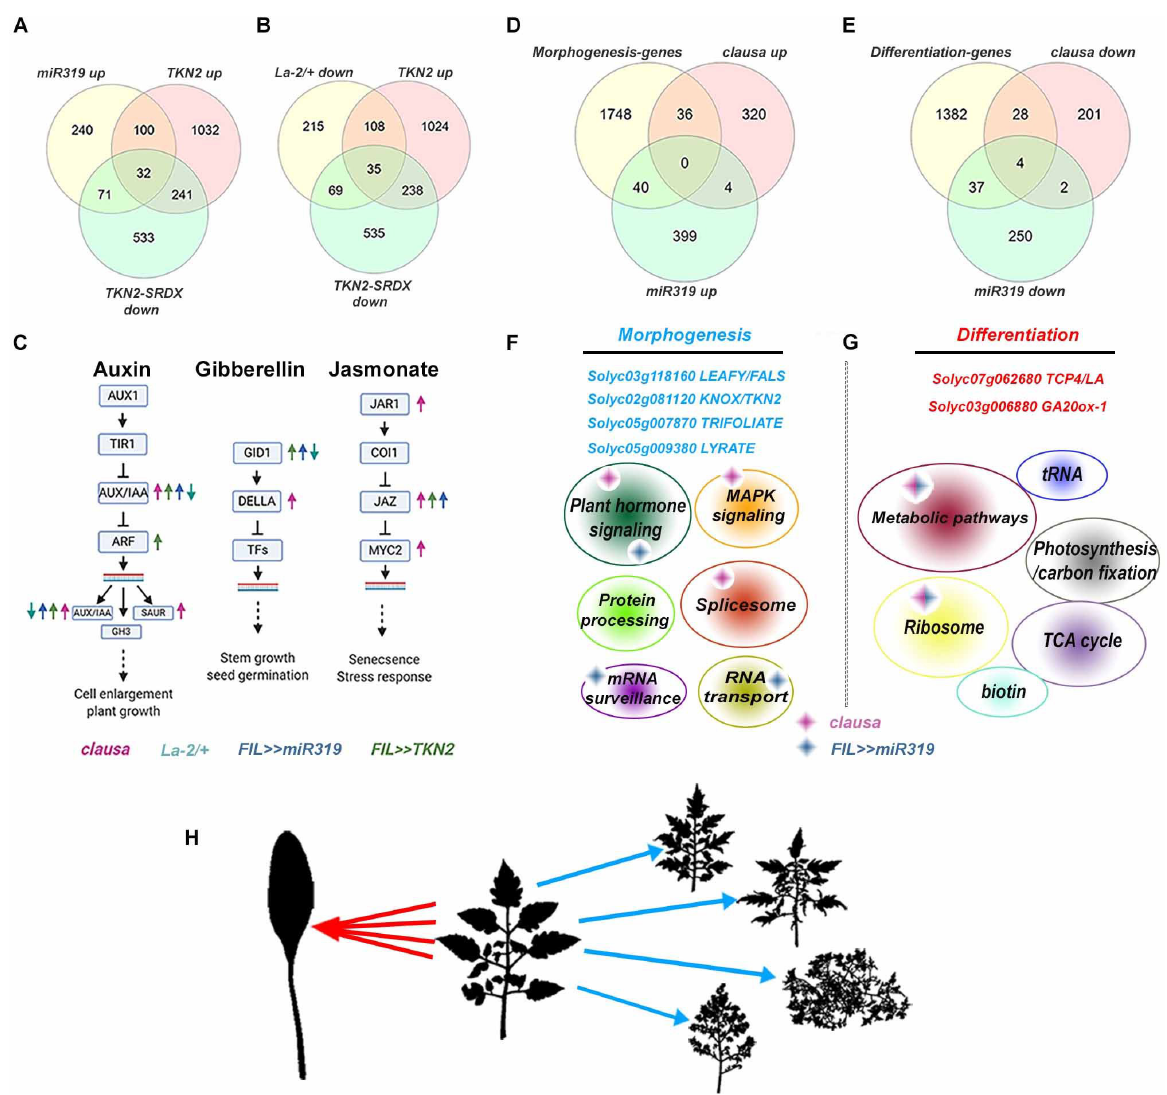
Fig 7. Global expression analyses of LA, CLAU and TKN2. ( A-B ) Venn diagrams depicting co-regulated genes in LA and TKN2 genotypes. Roughly a third to half of the genes upregulated upon LA activity downregulation ( miR319 overexpression), or downregulated upon LA activity upregulation ( La-2/+ ), are co-regulated upon upregulation of TKN2 activity (overexpression of TKN2 ) and/or downregulation of the activity of TKN2 targets (overexpression of TKN2-SRDX ). ( C ) Hormone signaling pathways co-regulated in the different genotypes. Arrow color corresponds with genotypes provided below, arrow direction indicates up or down regulation. ( D-G ) CLAU and LA promote differentiation in partially discrete pathways. Morphogenesis and differentiation genes were identified from a published dataset (Ichihashi et al., 2014). 1824 genes fit the condition of m+P3 exp > P4 exp > P5 exp > P6 exp and are considered "Morphogenesis" genes. 1451 genes fit the condition of m+P3 exp < P4 exp < P5 exp < P6 exp and are considered "Differentiation" genes. ( D ) "Morphogenetic" genes, as a group, are significantly enriched in the upregulated group in clausa (p < 0.014) and pFIL >> miR319 (p < 0.044). (F) Known morphogenesis genes identified that validate the methodology are listed in blue. Cartoon depicts the pathways significantly enriched in morphogenesis genes, denoting significant upregulation in clausa (pink diamond) and FIL >> miR319 (blue diamond). None of the genes overlap, and both common and distinct pathways are represented in the two genotypes. Fisher’s exact test was used to calculate statistical significance of KEGG pathway enrichment; p-values were corrected by calculating false discovery rate (FDR) using the Benjamini Hochberg test, corrected p-value < 0.05. ( E ) "Differentiation" genes, as a group, are significantly enriched in the downregulated group in clausa (p < 0.0001) and pFIL >> miR319 (p < 0.0001). ( G ) Known differentiation genes identified that validate the methodology are listed in red.—Cartoon depicts the pathways significantly enriched in differentiation genes, denoting significant downregulation in clausa (pink diamond) and pFIL >> miR319 (blue diamond). Only common pathways are represented in the two genotypes, and 10–15% of the genes overlap. Fisher’s exact test was used to calculate statistical significance of KEGG pathway enrichment; p-values were corrected by calculating FDR using the Banjamini Hochberg test, corrected p-value < 0.05. ( H ) Cartoon depicting morphogenesis and differentiation pathways. Different morphogenetic genes generate different pathways (blue arrows) that result in different patterning with similar leaf complexity. Different as well as overlapping differentiation genes generate different, partially overlapping pathways (red arrows) that, in the most simple leaved, differentiated form, look similar in addition to having equal complexity. See also Figs 8 and S1, S4 and S6 and S3 and S4.